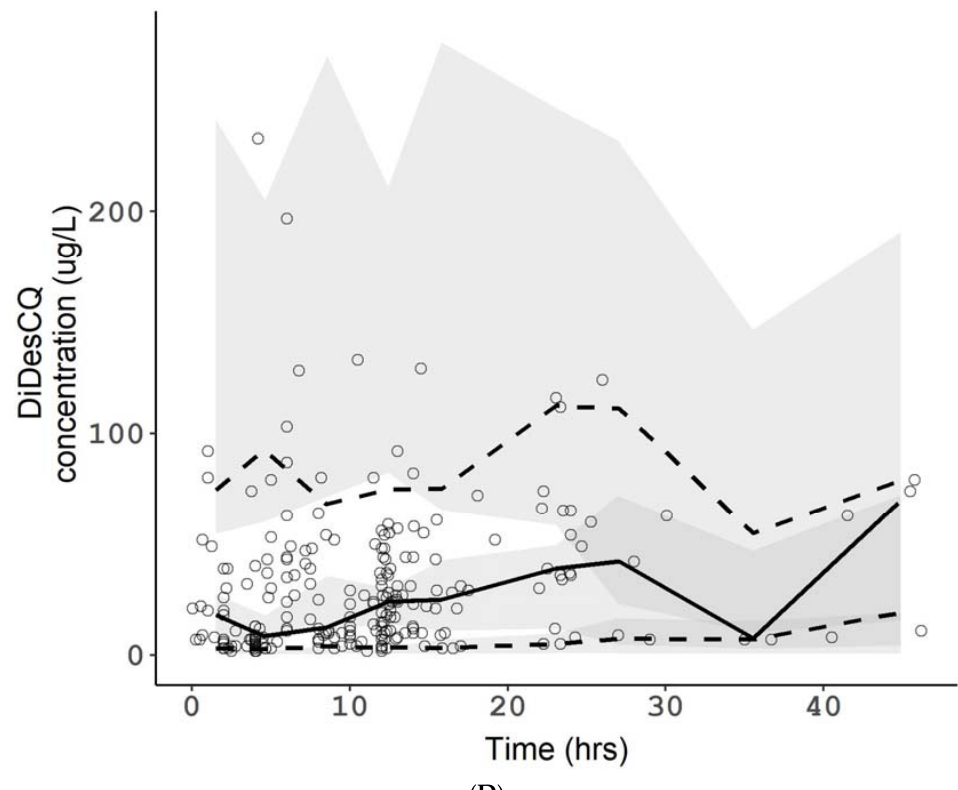
Figure 4. Visual predictive checks of HCQ ( A ), DesHCQ ( B ), DesCQ ( C ), and DiDesCQ ( D ). In each plot, open circles represent observed concentrations. The solid line represents the median of the observed concentrations. The dashed lines represent the 5th and the 95th percentiles of the observed concentrations. The shaded area represents the 90% confidence interval of the 5th, 50th, and 95th percentiles of the simulated concentrations. The horizontal dotted lines represent the lower limit of quantification (LLOQ) of the respective compounds.